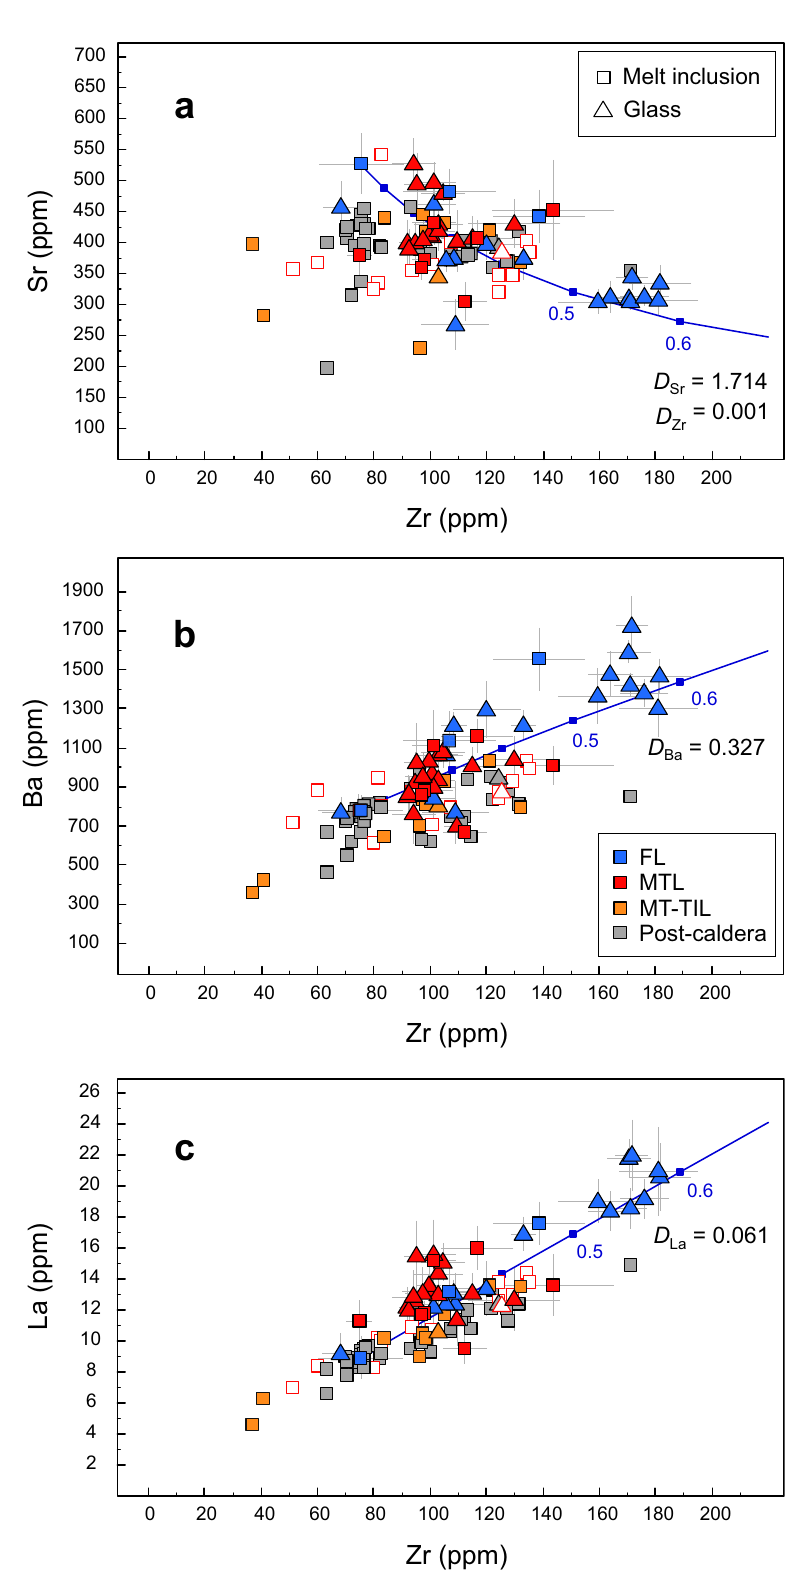
Fig. 4 Trace element concentrations measured in PEC-corrected plagioclase-hosted MI and matrix glass in samples of the FL eruption. Panels are presented in order of increasing incompatibility in plagioclase, from ( a ) Zr vs Sr, ( b ) Zr vs Ba to ( c ) Zr vs La. The melt differentiation trend for the FL eruption is modelled using the most primitive MI as the starting composition. Each square along the fractional crystallisation path represents an increase in crystal fraction of 0.1. Trace element concentrations in plagioclase-hosted MI and matrix glass of the MTL eruption are also presented. Literature data from samples of post-caldera activity 20,23 and the MT-TIL eruption 23 are also shown. Literature data from samples of the MTL eruption 23 are highlighted by the open squares and triangles with the red outline. Grey error bars represent the analytical uncertainty (2 σ ) for samples from this